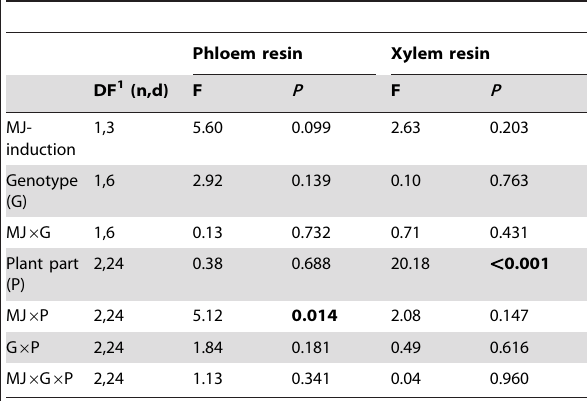
Table 2. Allocation of constitutive and induced non-volatile resin across different pine